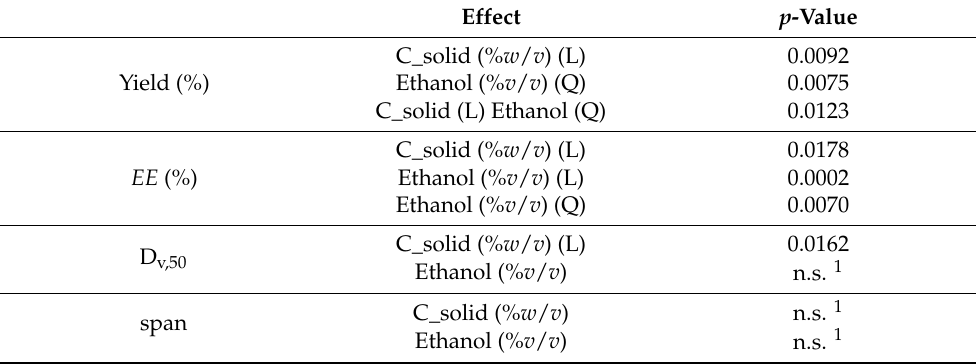
Table 4. Effects component (linear and or quadratic) with ANOVA p -value for each